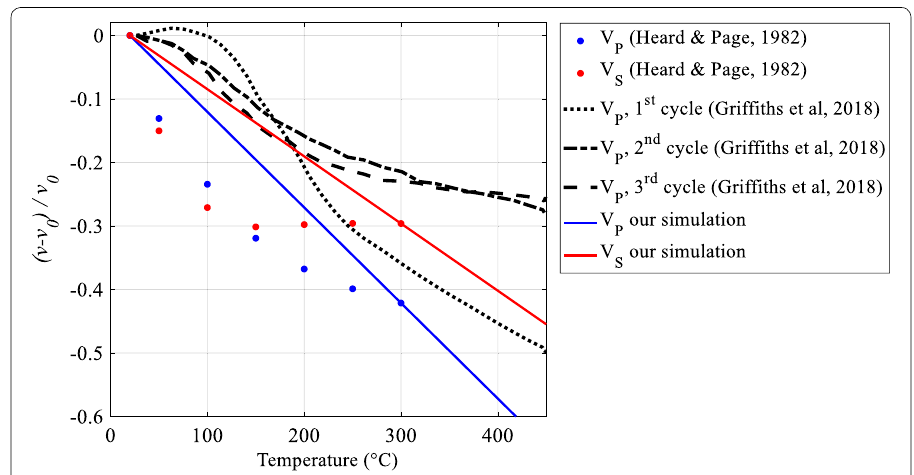
Fig. 12 Relative variation of P-wave speed measured in the laboratory during cycles 1–3 (black line), as a function of the temperature on Westerly Granite (Griffiths et al. 2018). The blue and red dots represent, respectively, the relative variation P-wave speed and for S-wave speed deduced from the E ( T ), K ( T ) and density measurements of (Heard and Page 1982) also for Westerly Granite. The blue and red lines represent, respectively, the relative variation P-wave speed and for S-wave speed introduced in our simulation to take into account the experimental measurements of (Heard and Page